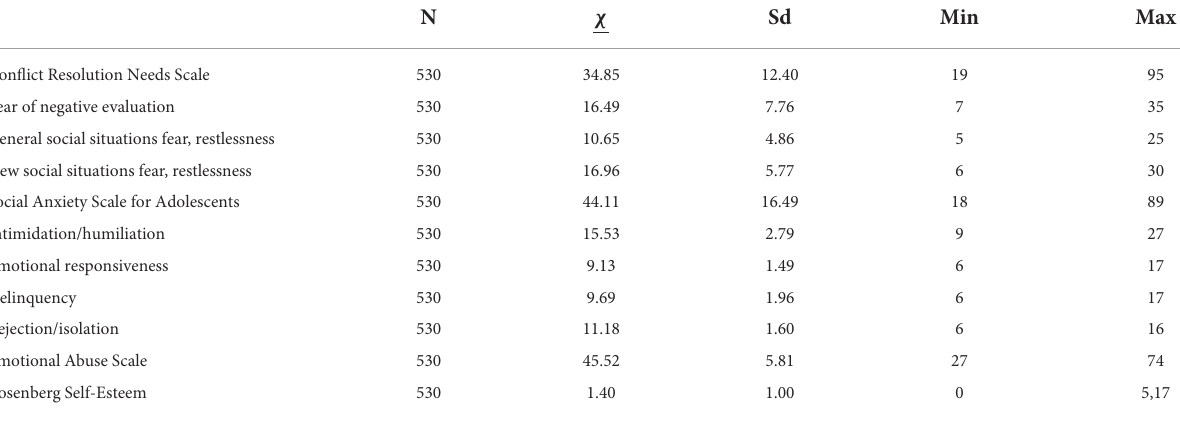
TABLE 2 Conflict resolution needs of students, social anxiety for adolescents, emotional abuse, and Rosenberg Self-Esteem Scores from the scale. N χ Sd Min Max